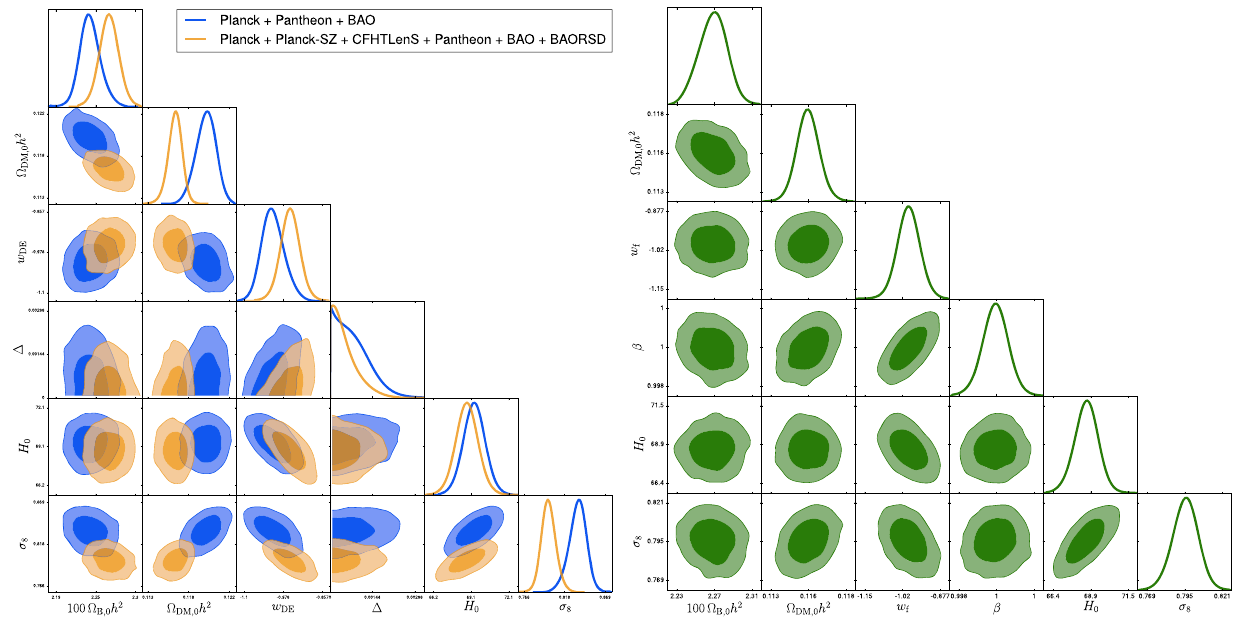
Fig. 5 The one-dimensional posterior distribution and two- dimensional posterior contours with 68% and 95% confidence limits for the selected cosmological parameters of Barrow cosmology